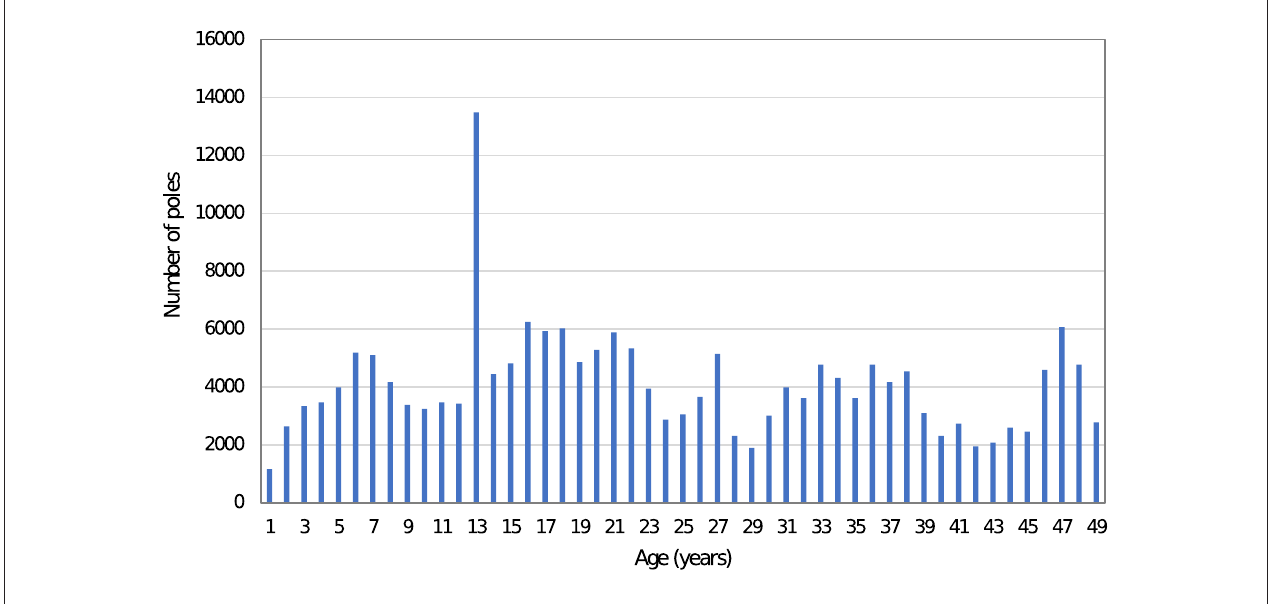
FIGURE 5 | Age distribution of